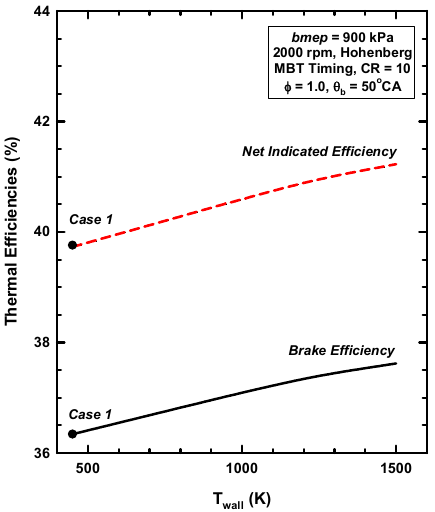
Figure 7. Brake and net indicated thermal efficiencies as functions of cylinder wall temperature.